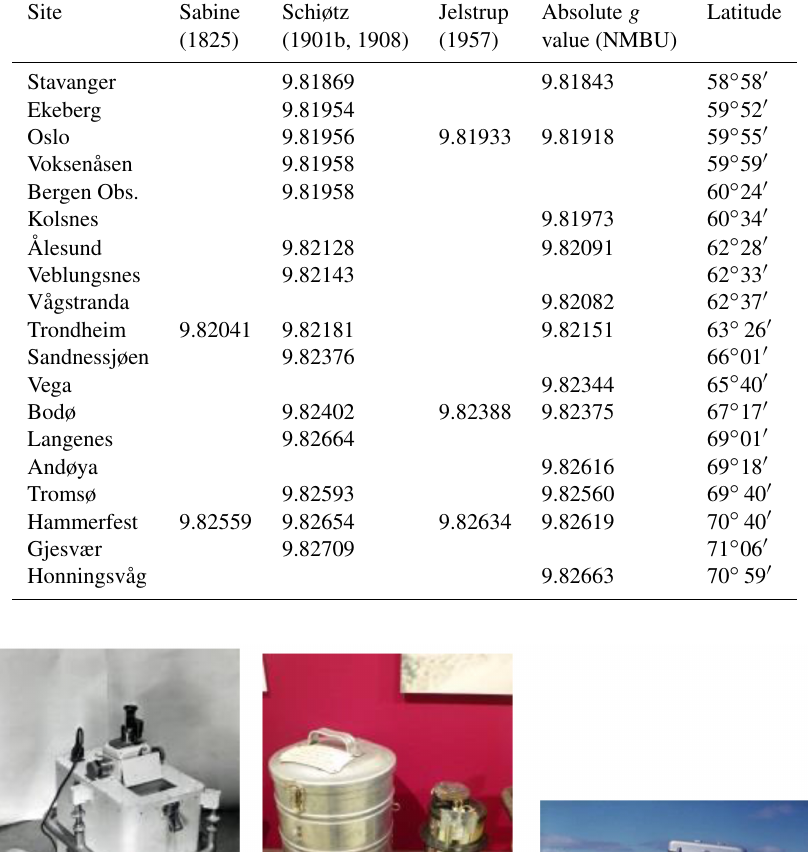
Table 2. Historical and modern gravity values referring to the geoid.